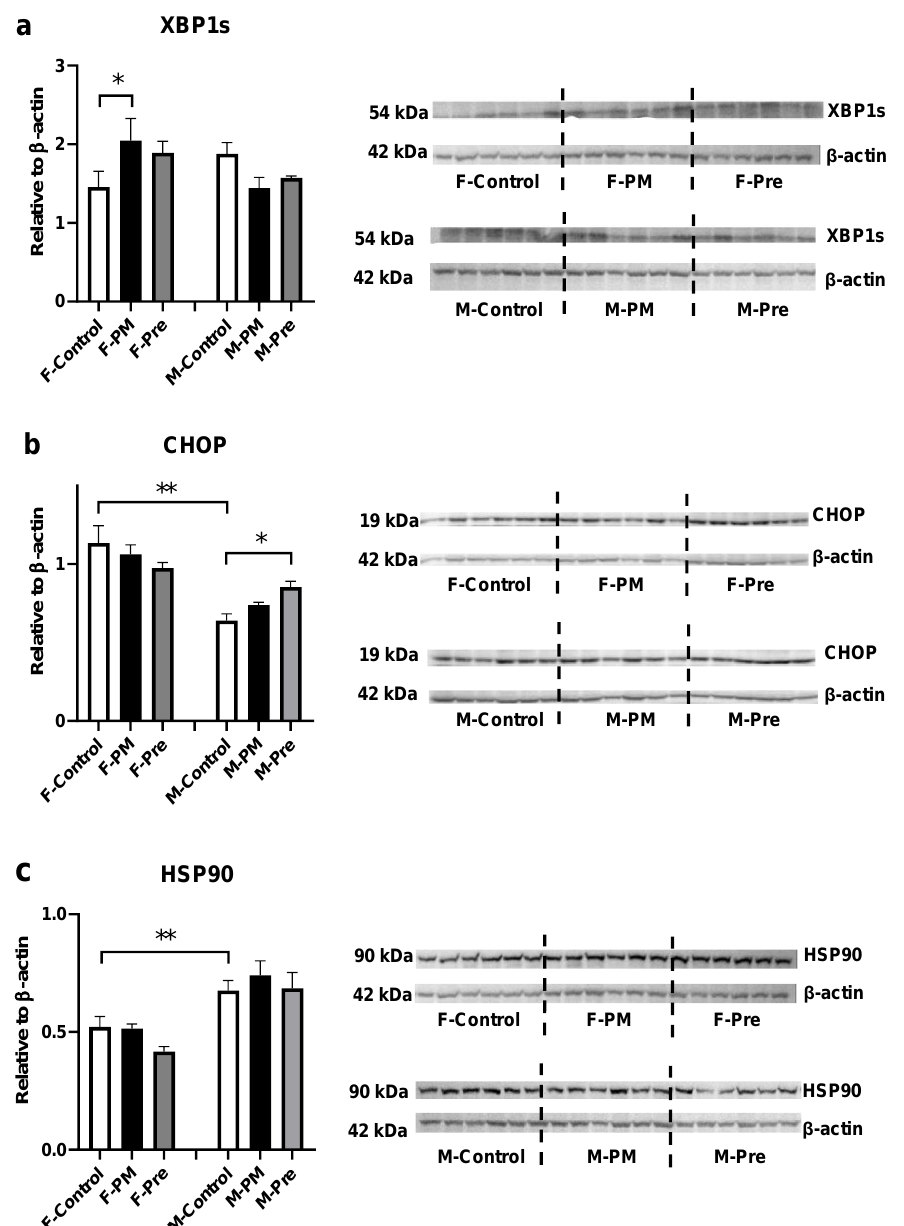
Figure 2. ER Stress Markers in Female and Male Offspring. Protein expression levels of XBP1s ( a ), CHOP ( b ), and HSP90 ( c ). Results are expressed as mean ± SEM, n = 6. * p < 0.05, ** p < 0.01. CHOP: C/EBP homologous protein, HSP90: heat shock protein 90, XBP1s: X-box binding protein 1 spliced. PM: offspring from dams continuously exposed to PM2.5; Pre: offspring from dams exposed to PM2.5 before conception only.